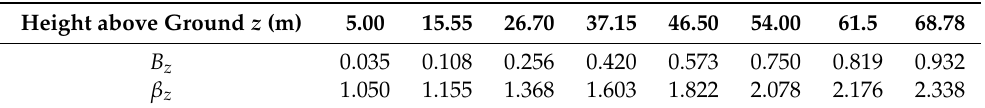
Table 6. Wind-load adjustment factor.